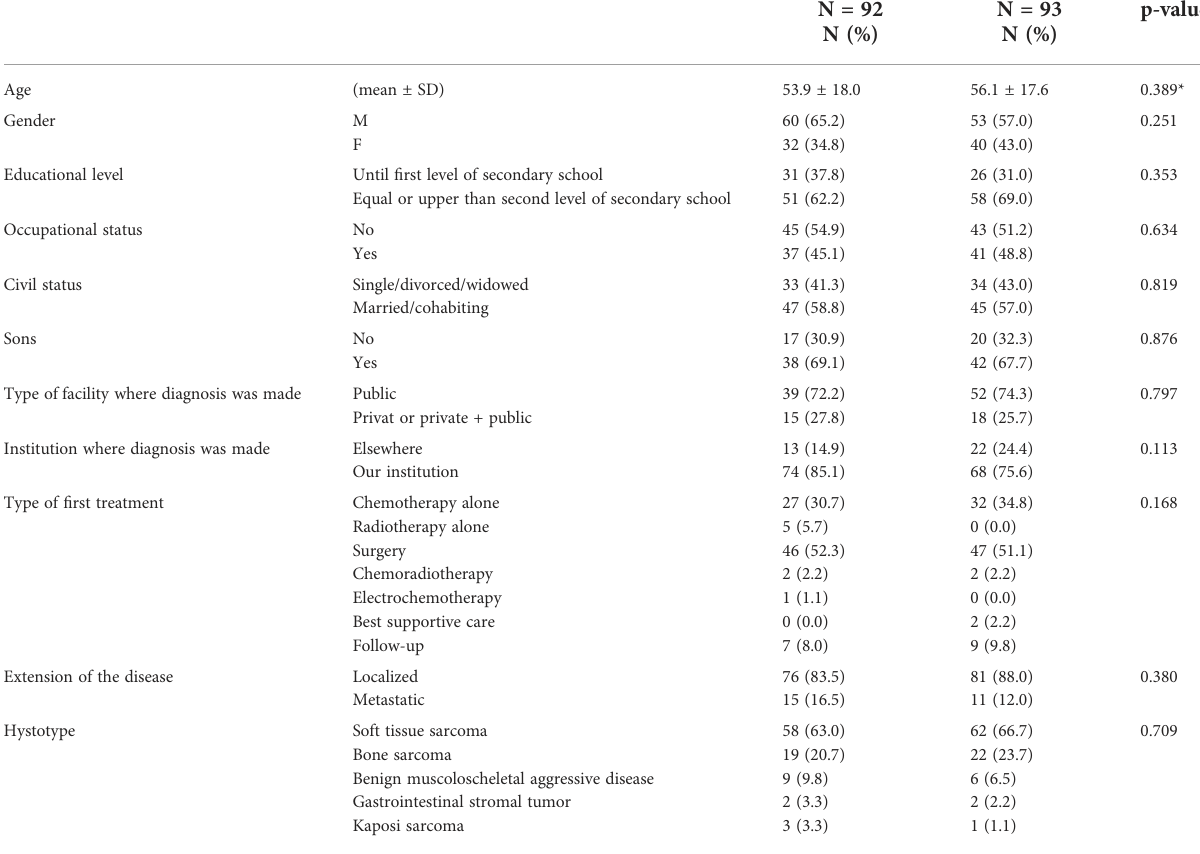
TABLE 1 Patients ’ characteristics in Control and Covid groups. N =